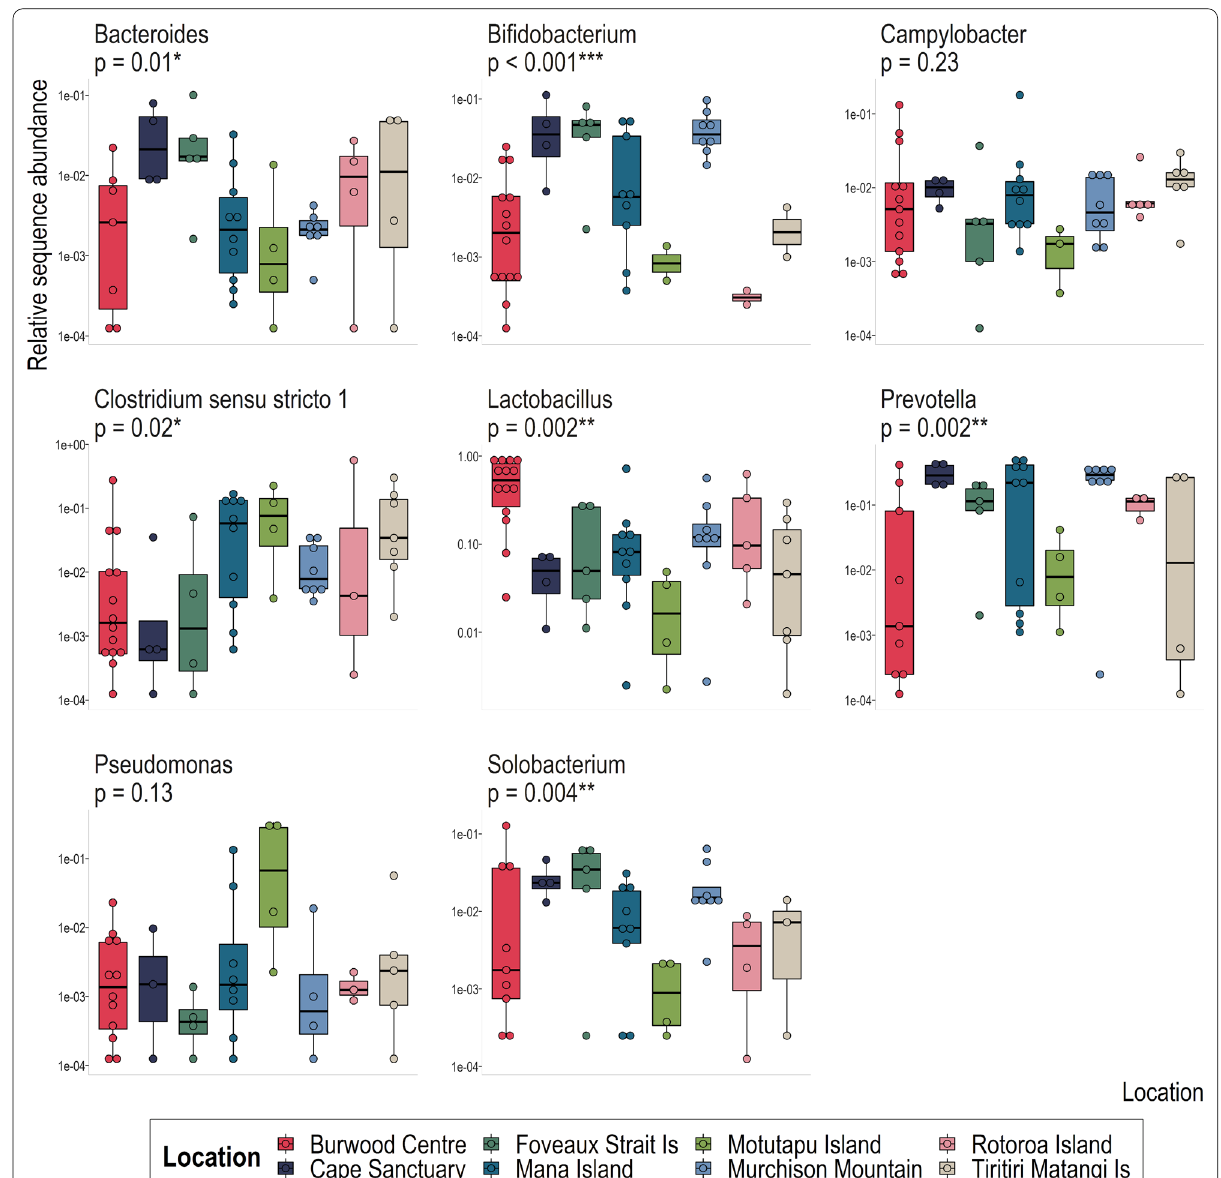
Fig. 3 Distribution of core bacterial genera by location, with Kruskal–Wallis p -value displayed for each taxon. Relative 16S rRNA gene sequence abundances are log10 transformed. Significant comparisons are denoted by asterisks ( p < 0.05